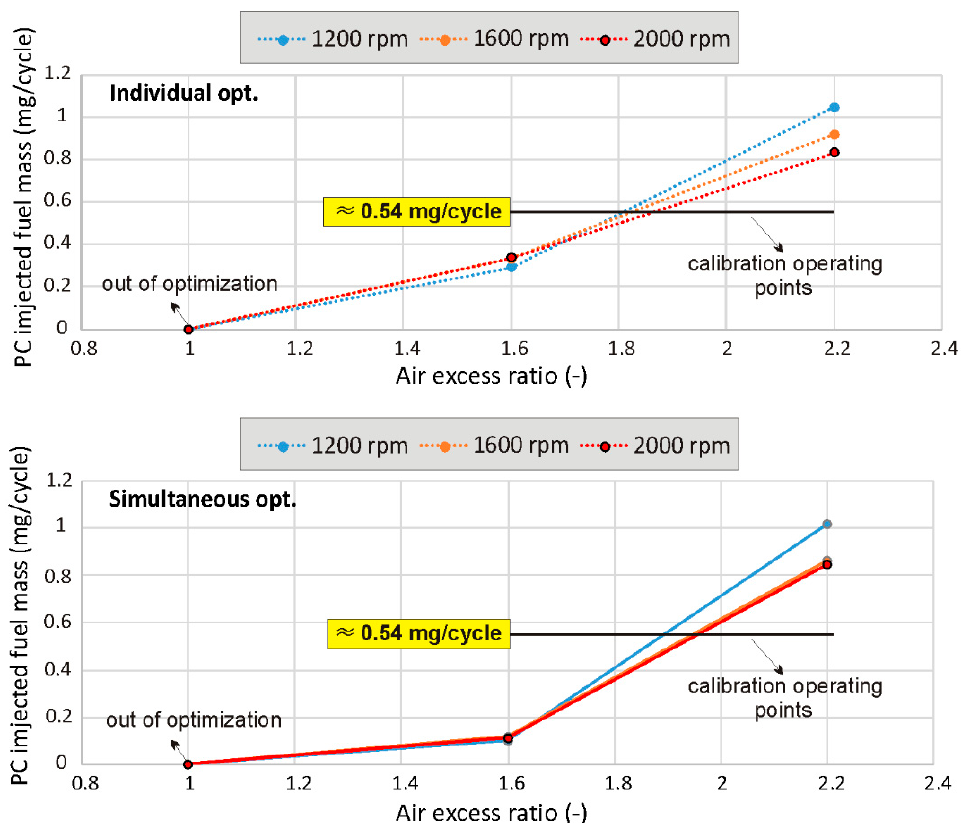
Figure 14. Optimized pre-chamber injected fuel mass per cycle for individual (upper diagram) and simultaneous optimization (lower diagram).